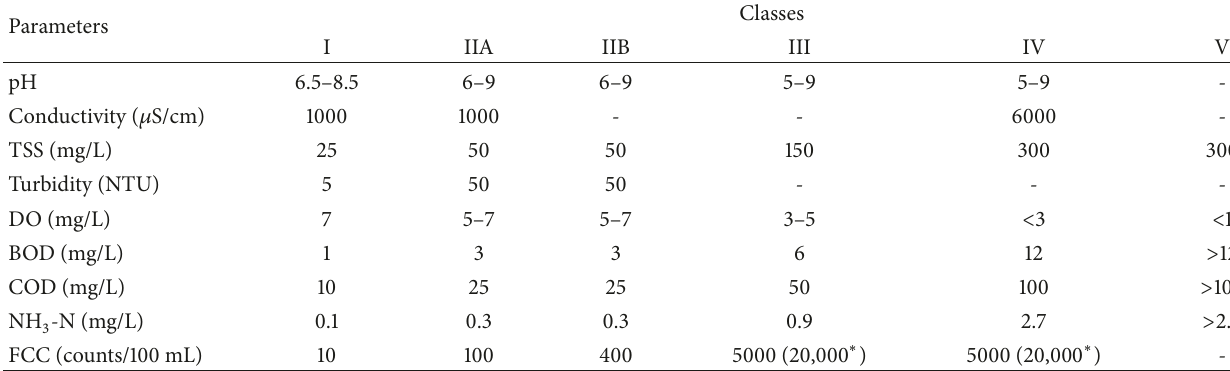
Table 3: The guidelines of water quality according to the National Water Quality Standards (NWQS) for